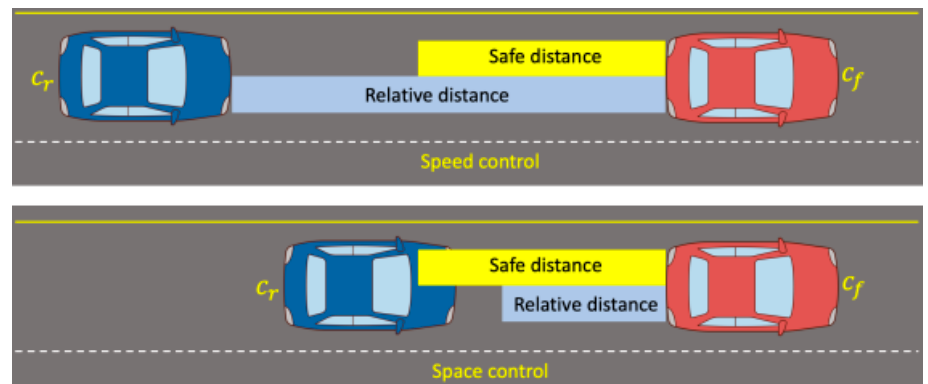
Figure 2. Schematic diagram of ACC operation principle.